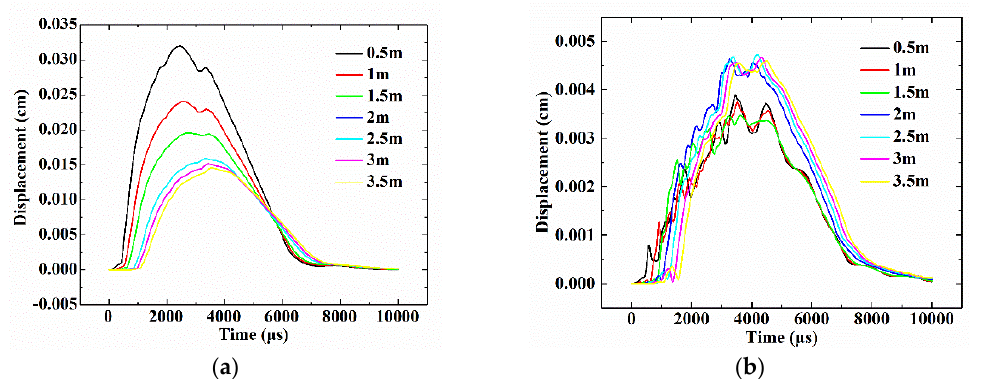
Figure 15. Displacement-time curves of monitoring points at different directions: ( a ) displacement-time curves in the primary impact direction; ( b ) displacement-time curves in the secondary impact direction.